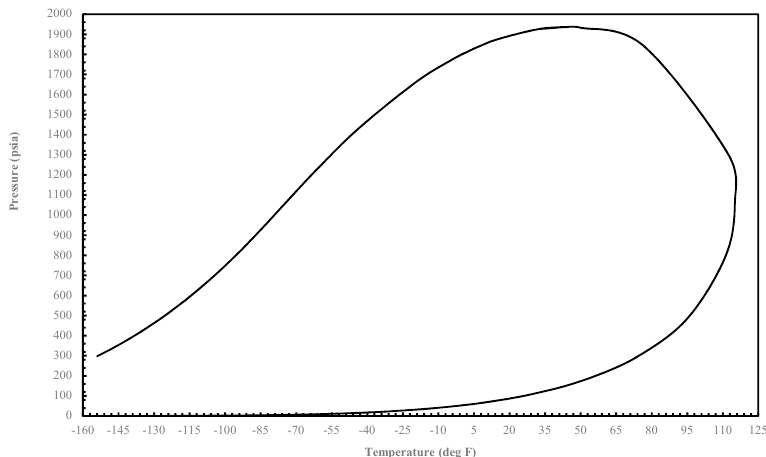
Figure 3. Phase diagram of initial gas mixture.